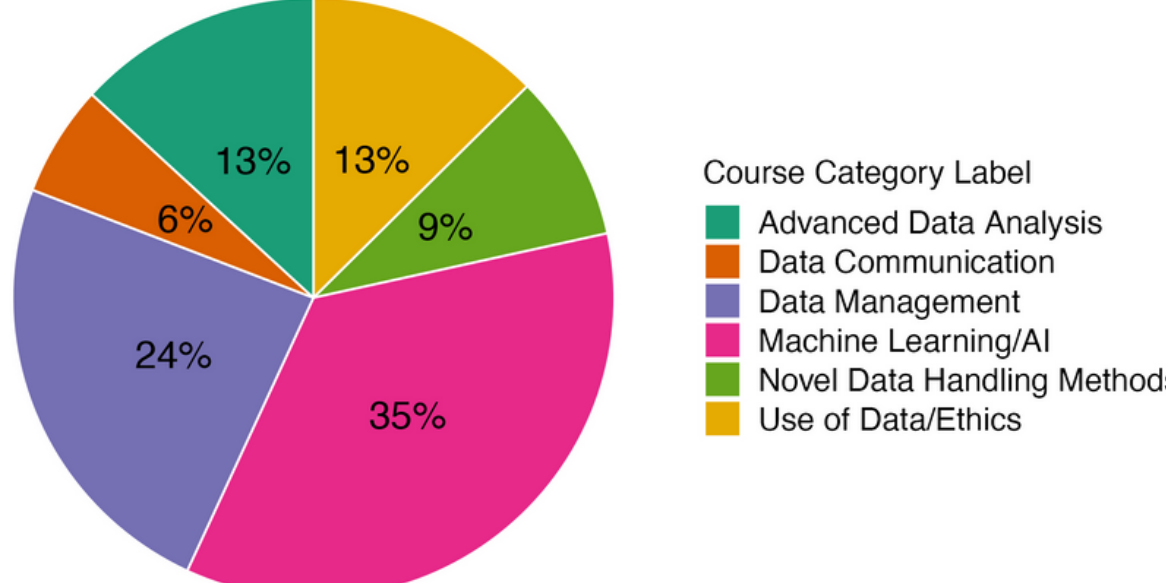
Figure 1. Overall distribution of current coursework in public health data science programs. Courses at the top 10 schools of public health in the United States and the top 10 global universities for social science and public health as ranked by the U.S. News & World Report are categorized across six salient domains. AI = artificial